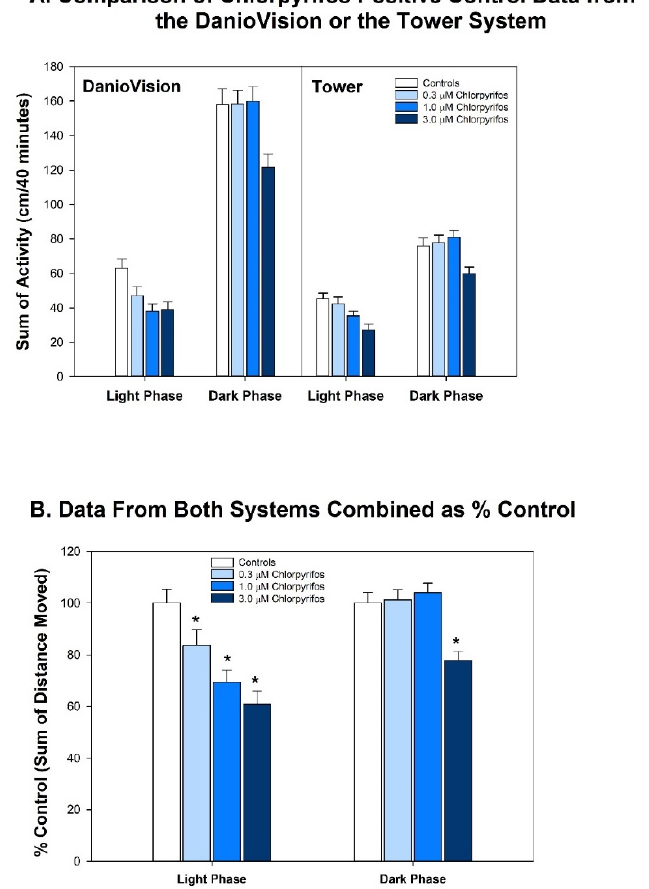
Figure 2. Comparison of the Developmental Chlorpyrifos Effect When Tested on Either the Dan- ioVision or Tower System. Upper Panel A shows the results when larvae treated with chlorpyrifos during development were tested on either the DanioVision system ( left panel) or Tower system ( right panel). Using an ANOVA with chlorpyrifos treatment and the system tested as independent variables, and locomotor activity as the dependent variable, it was found that there was an overall effect of chlorpyrifos ( p < 0.0001) and of the system used ( p < 0.0001), but that there was no interaction between those two variables ( p = 0.22). Because the effect of the chlorpyrifos did not depend on the system that was used for testing, the data from both systems were combined, expressed as a percent of control and analyzed to delineate the effect of chlorpyrifos (Panel B ). In this case the data were analyzed using an ANOVA (chlorpyrifos or Light/Dark period were independent variables and lo- comotor activity was the dependent variable). This analysis showed that there was an overall effect of chlorpyrifos ( p < 0.0001), Light/Dark period ( p < 0.0001), and that there was an interaction between the two ( p = 0.0003), meaning that the effect of chlorpyrifos was different depending on whether the